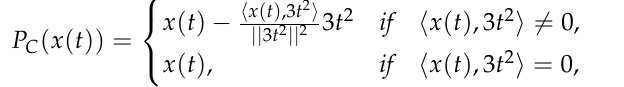
Figure 1. Example 1, Case I–Case IV;